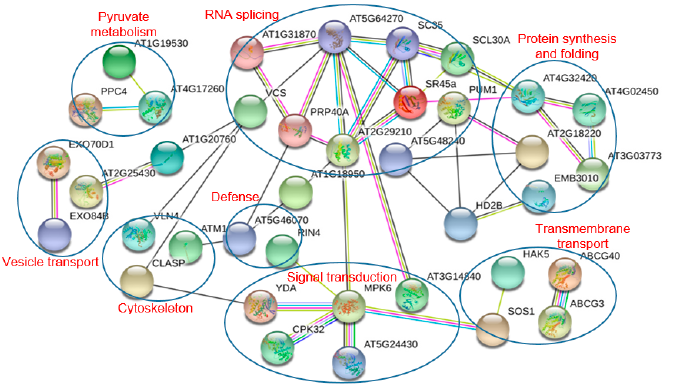
Figure 6. The protein-protein interaction (PPI) network of the differentially phosphorylated phosphoproteins in A. mongolicus roots under drought stress. The functional classification of the DPP group are shown in red. Edge color represents protein-protein associations among different proteins: blue for known interactions from curated database, pink for experimentally determined known interactions, green for predicted interactions base on gene neighborhood, red for predicted interactions base on gene fusions, dark blue for predicted interactions base on gene co-occurrence, yellow-green for predicted interactions base on textmining, black for predicted interactions base on co-expression, and light blue for predicted interactions base on protein homology.